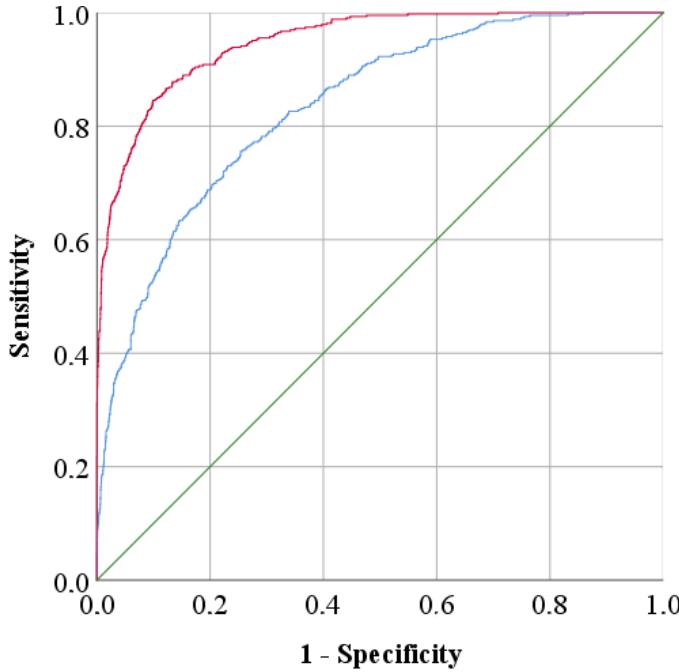
Figure 3. Histograms of the Pearson correlation coefficients and their respective distribution overlap for ( A ) the reference data (GC–FID-aligned data) and ( B ) after fourth root normalization. The yellow bar chart corresponds to the coefficients of the inter-location samples, while the blue bar chart refers to the intra-location correlation coefficients. The two confidence limits are represented as the green vertical line for the 95% CL and the red vertical line for the 99% CL.